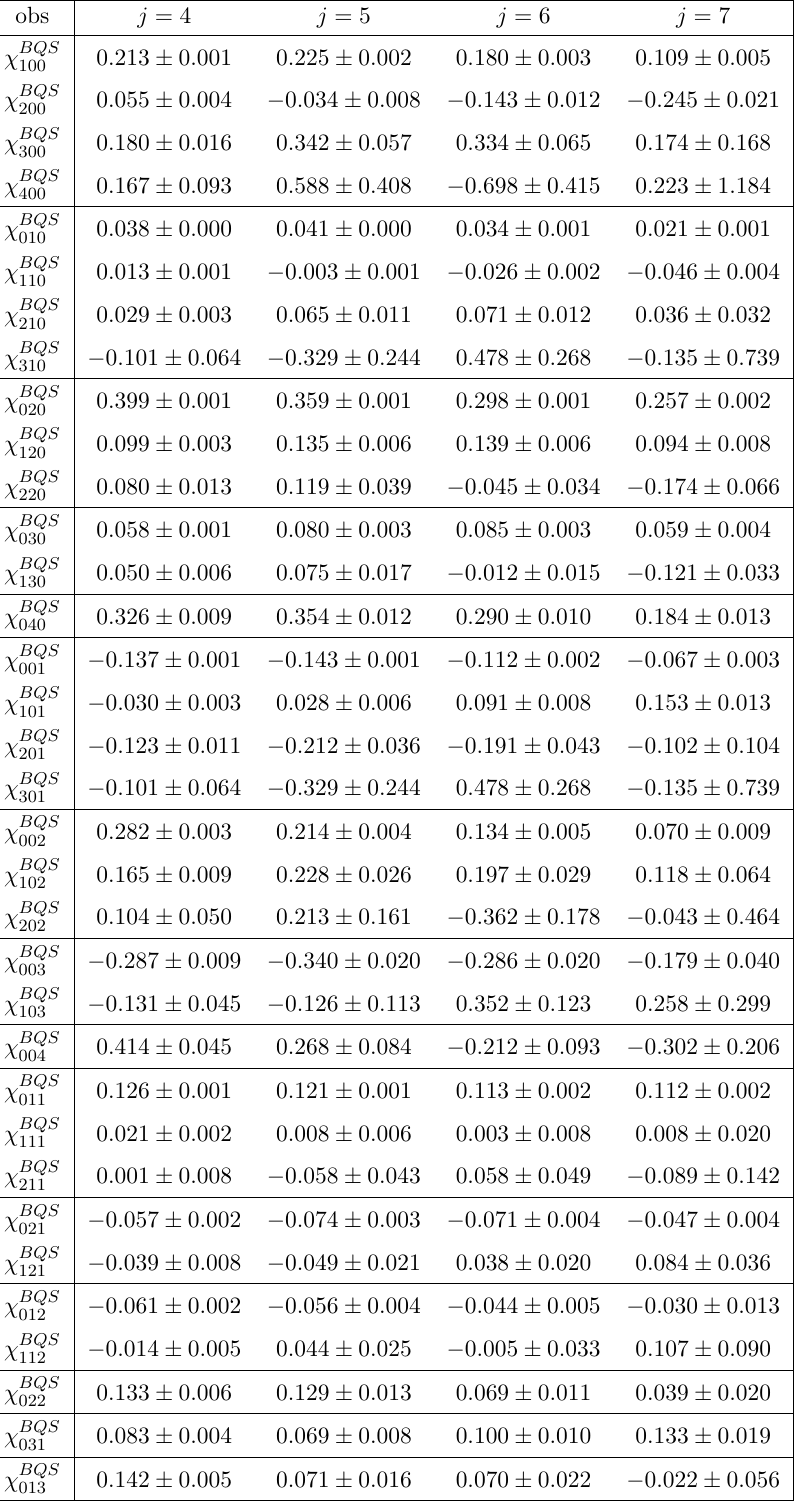
Table 6 . Raw data at T = 170 MeV and (cid:22) ( j )